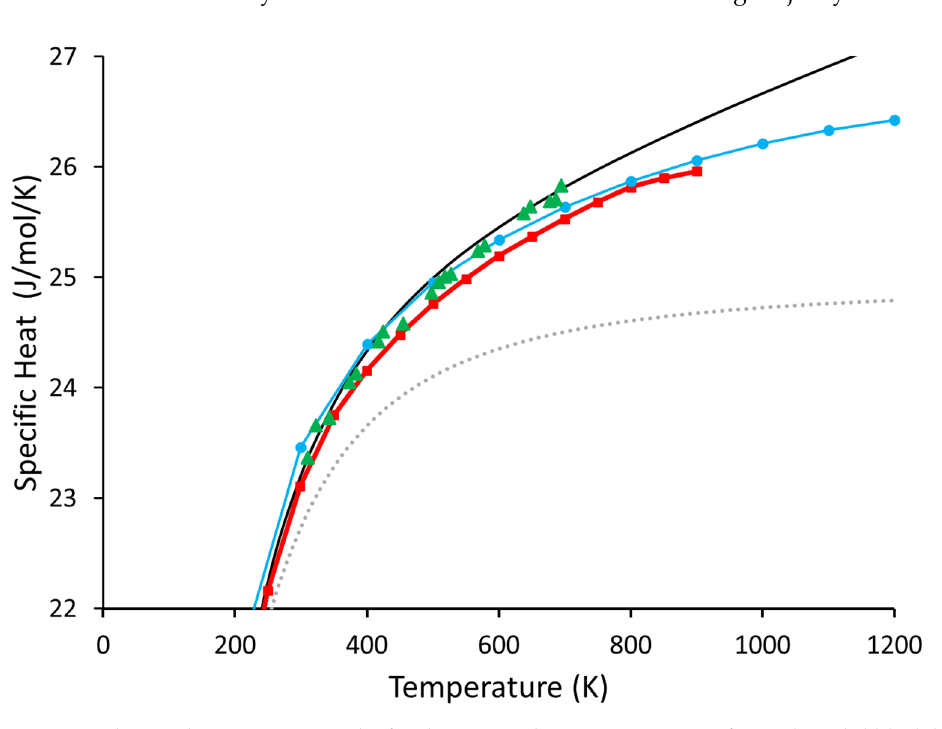
Table 3. Coefficients for Equation (1) for the temperature range 300 K to 1200 K for Ge (J/mol/K).